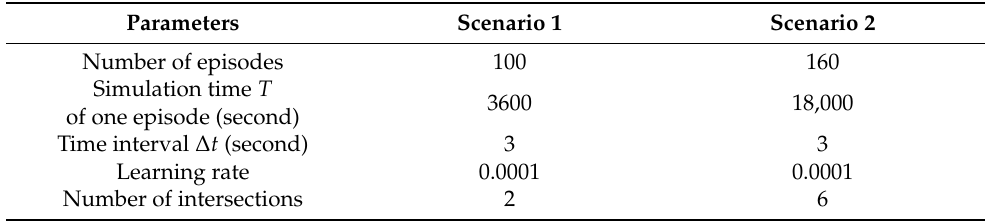
Table 1. Parameters used in the